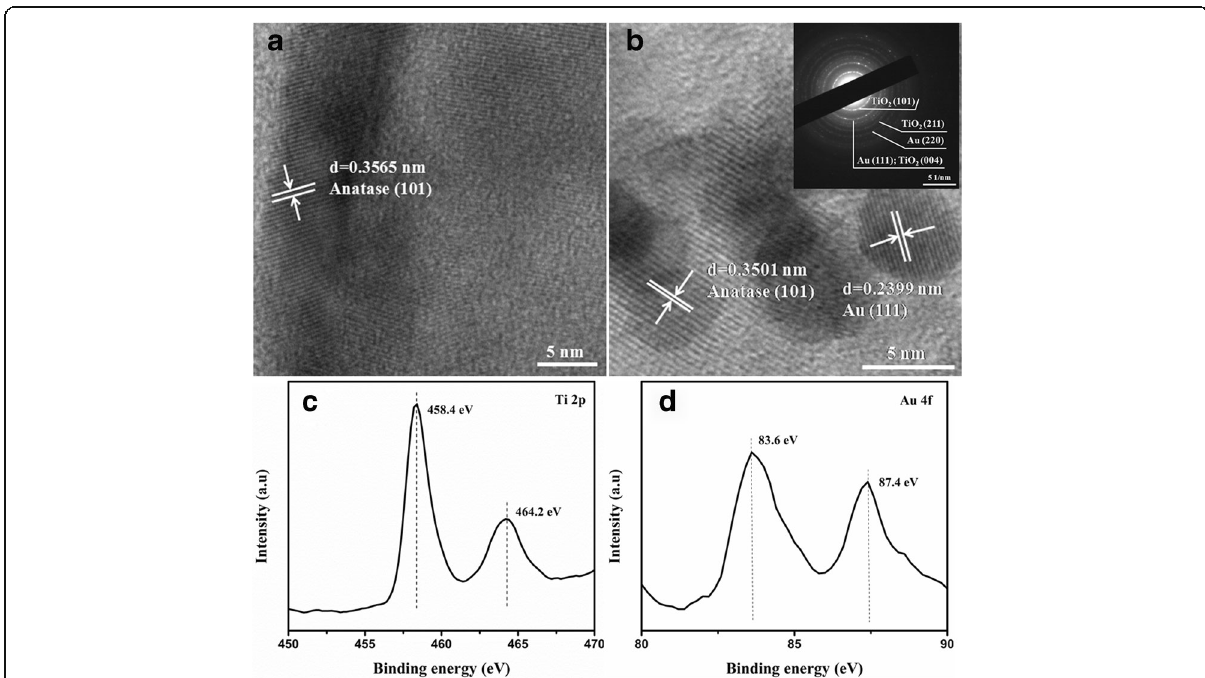
Fig. 4 HRTEM images of a TiO 2 and b Au-30@TiO 2 , in which the top right inset in b shows the SAED patterns of Au-30@TiO 2 nanostructure. High-resolution XPS of c Ti 2p and d Au 4f of Au-30@TiO 2